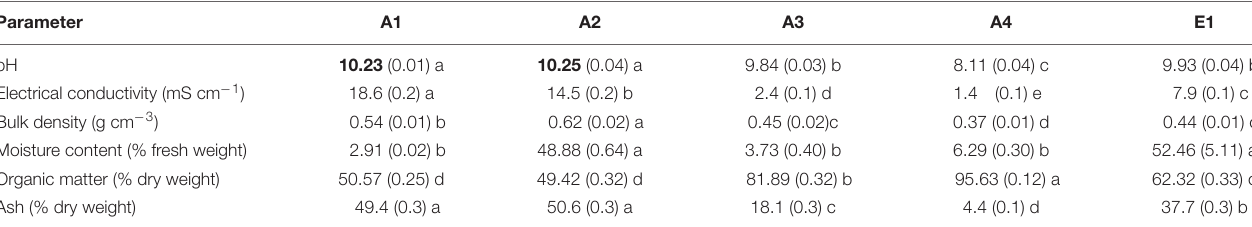
TABLE 1 | Physicochemical characterization of chars from thermocatalytic reforming of digestate (A1), poultry litter (A2), and wood pellet (A3) and from pyrogasification of wood pellet (A4) and brushwood (E1). Parameter